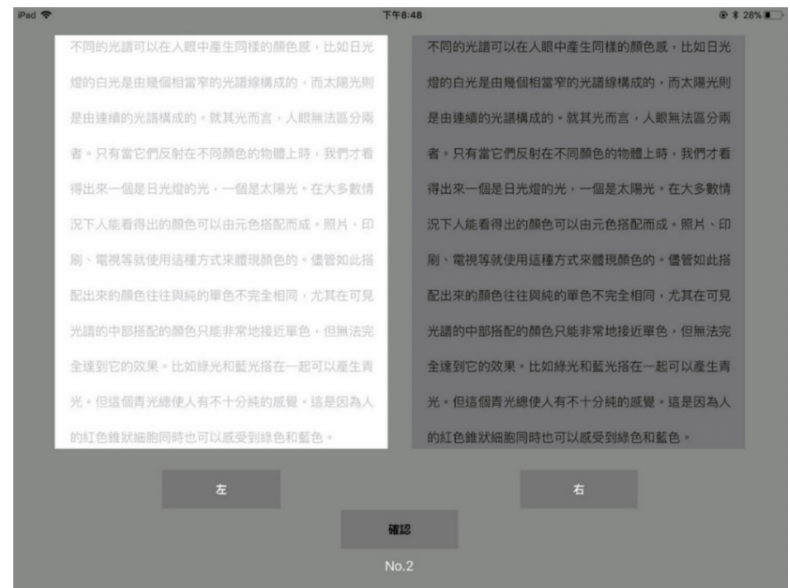
Figure 3. An example of the stimulus for paired-comparison on the iPad Air